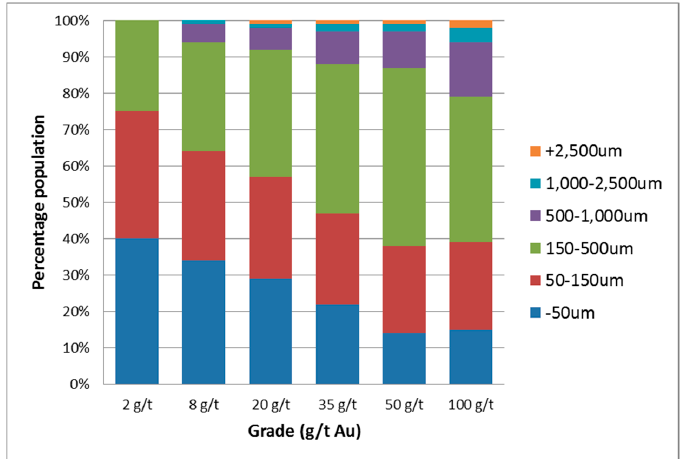
Figure 7. Gold particle size distribution by mass across different grades for the Target Zone Main vein.